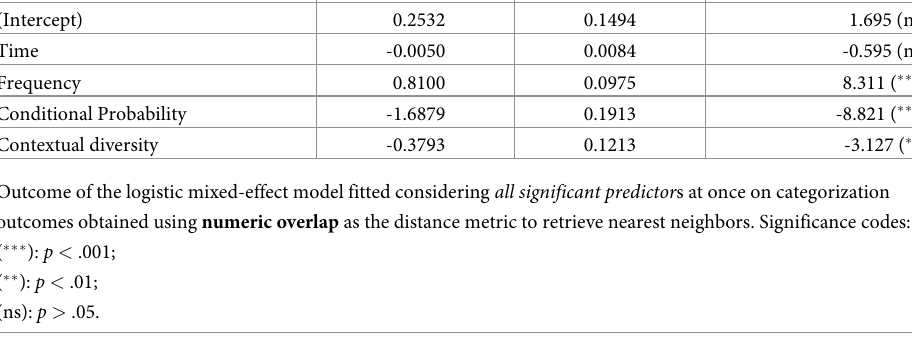
Table 4. Logistic mixed-effect model considering all predictors—Numeric overlap distance.